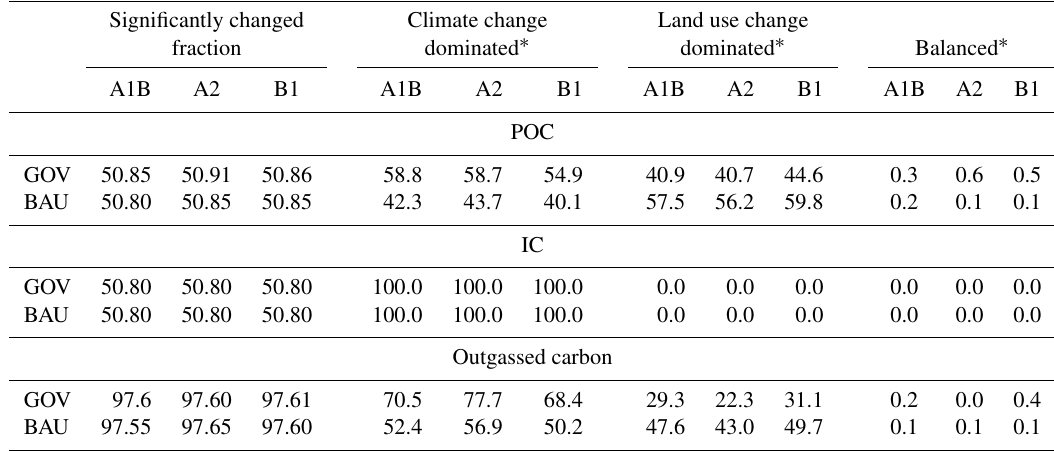
Table 3. Proportion (%) of area dominated by climate or land use change